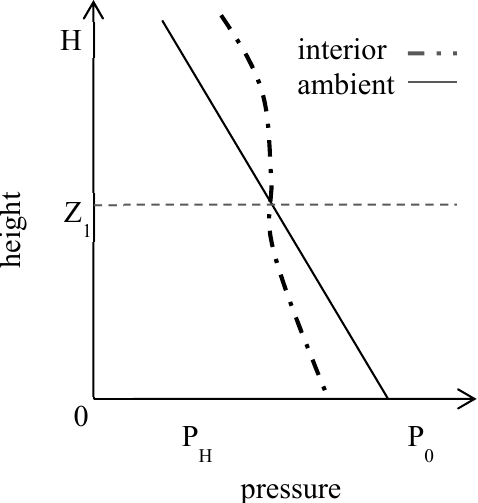
Figure 1. Pressure distribution and neutral level height. Linden [9] reported that neutral level height is dependent on effective area, which is determined in turn by vent area. A study by Fitzgerald and Woods [10] revealed that neutral level height is also dependent on the ratio of upper to lower vent dimensions.